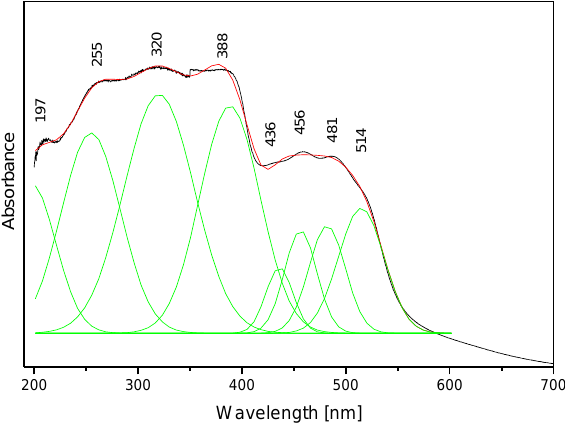
Figure 8. The electron absorption spectrum of the TPa-NH 2 molecule.